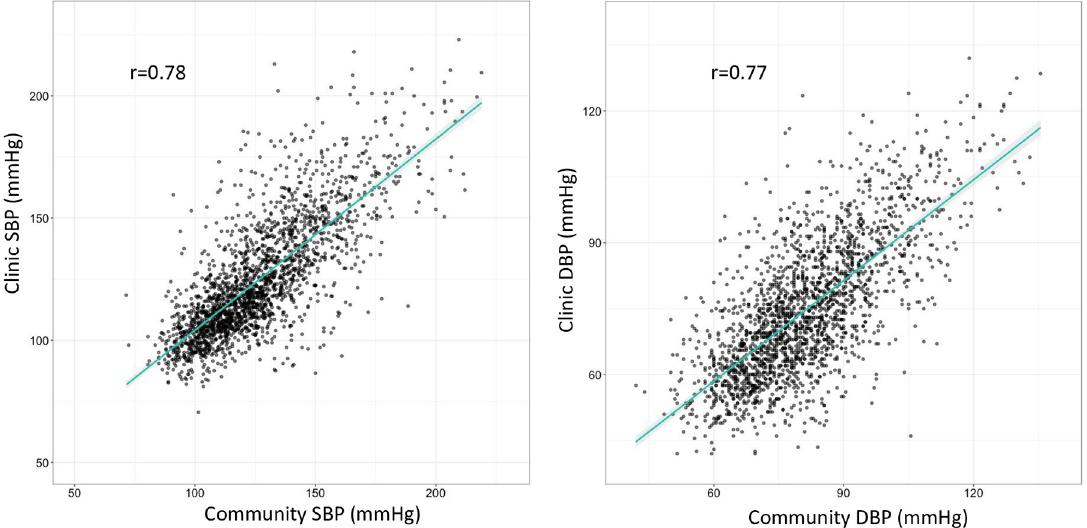
Fig 1. Correlation of systolic and diastolic blood pressure in mmHg in the clinic versus community measurement (N = 2123). The line represents the linear regression between clinic and community